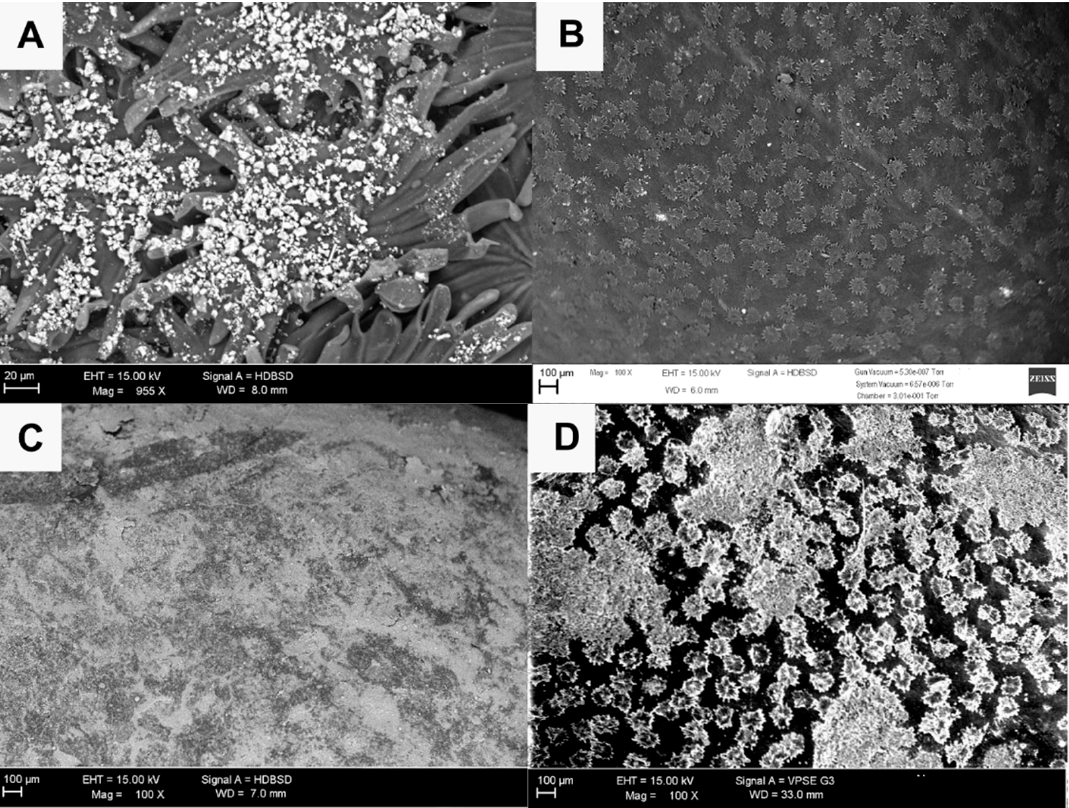
Figure 2. ESEM observations of treated and untreated olive leaves. ( A ) Accumulation of CHA-zeolitite on stellar trichomes that cover the lower surface of the olive leaves; ( B ) Upper surface of test olive leaf; ( C ) Olive leaf treated with kaolin; ( D ) Olive leaf treated with CHA-zeolitite.